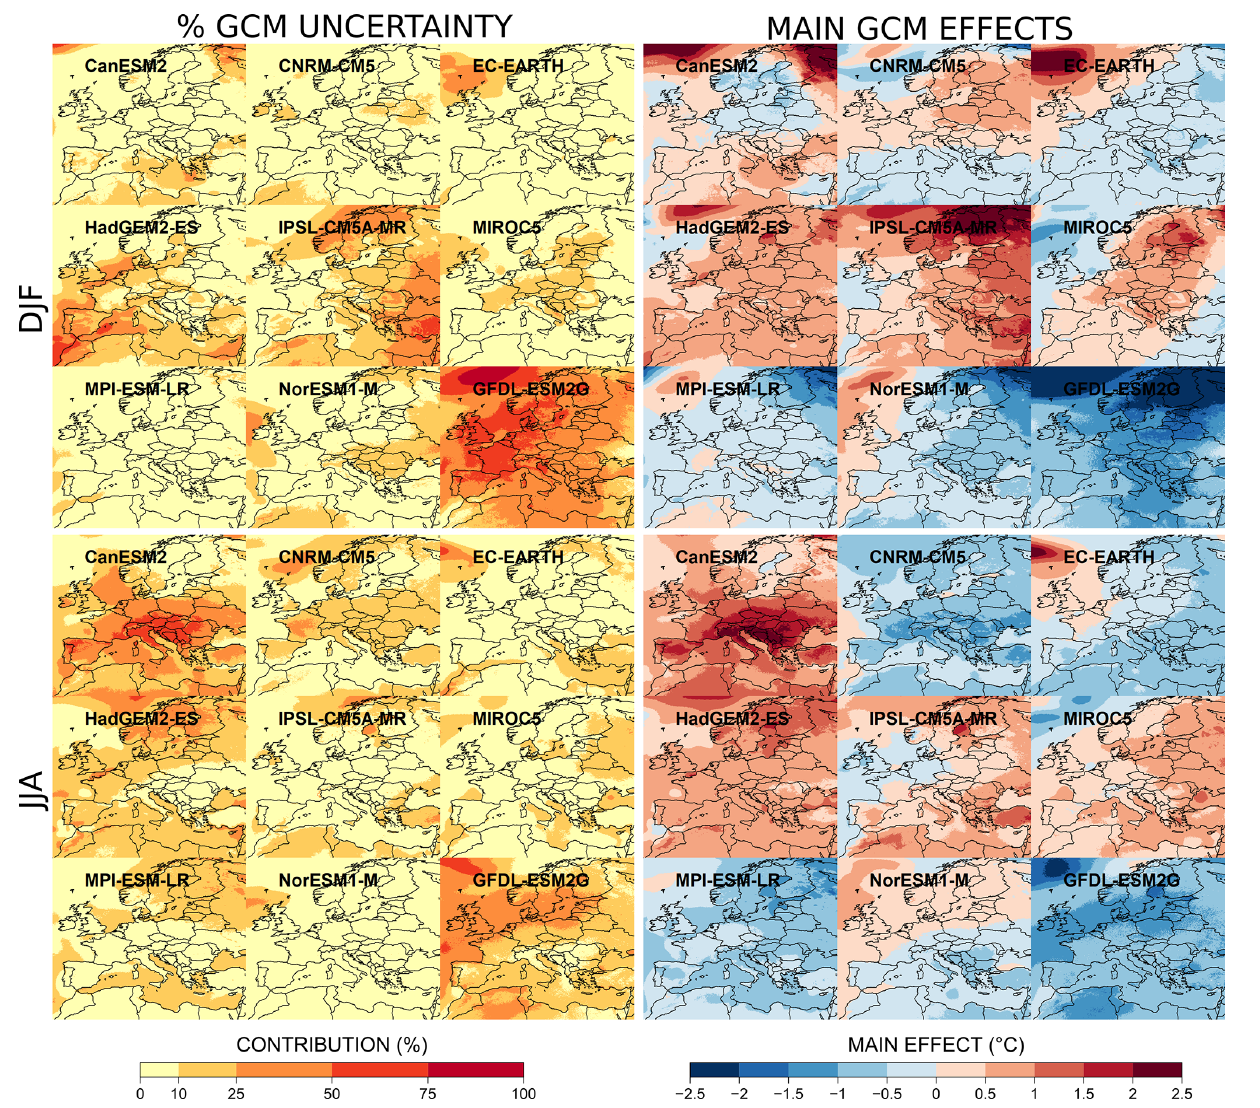
Figure 9. Fraction of GCM uncertainty (left plots) and main GCM effects (right plots) for each GCM for absolute temperature changes in winter (DJF) and summer (JJA) at the end of the 21st century (2071–2099) compared to the period